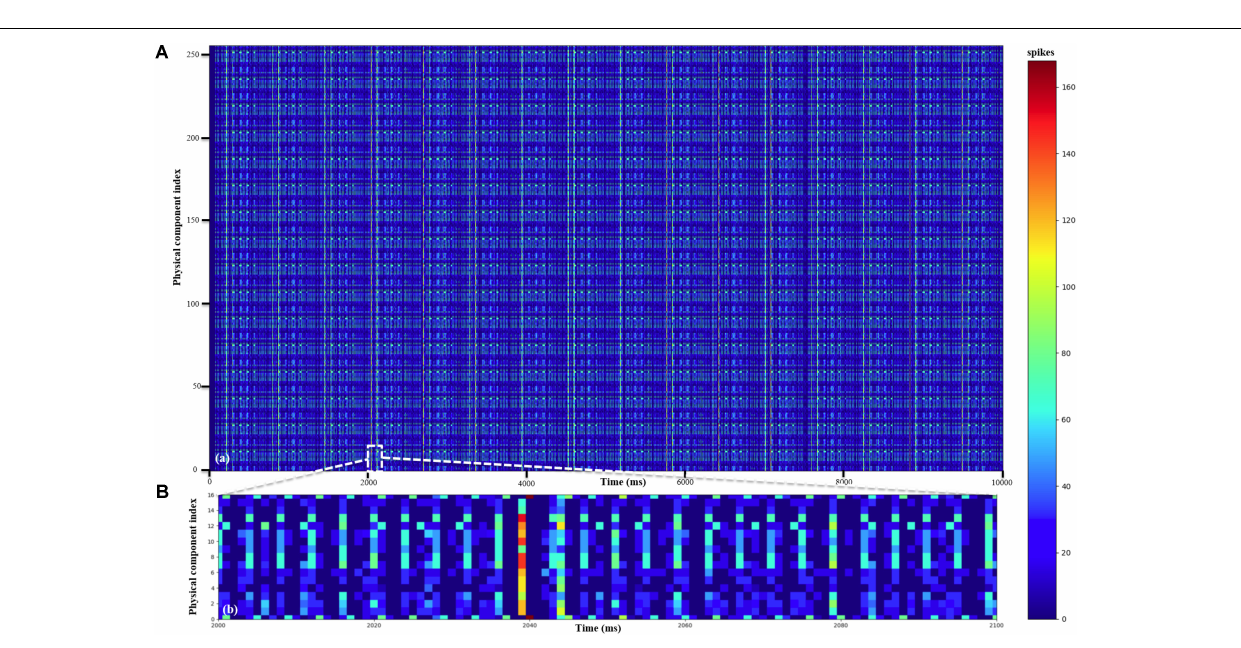
2k TM LIF neurons implemented with one physical